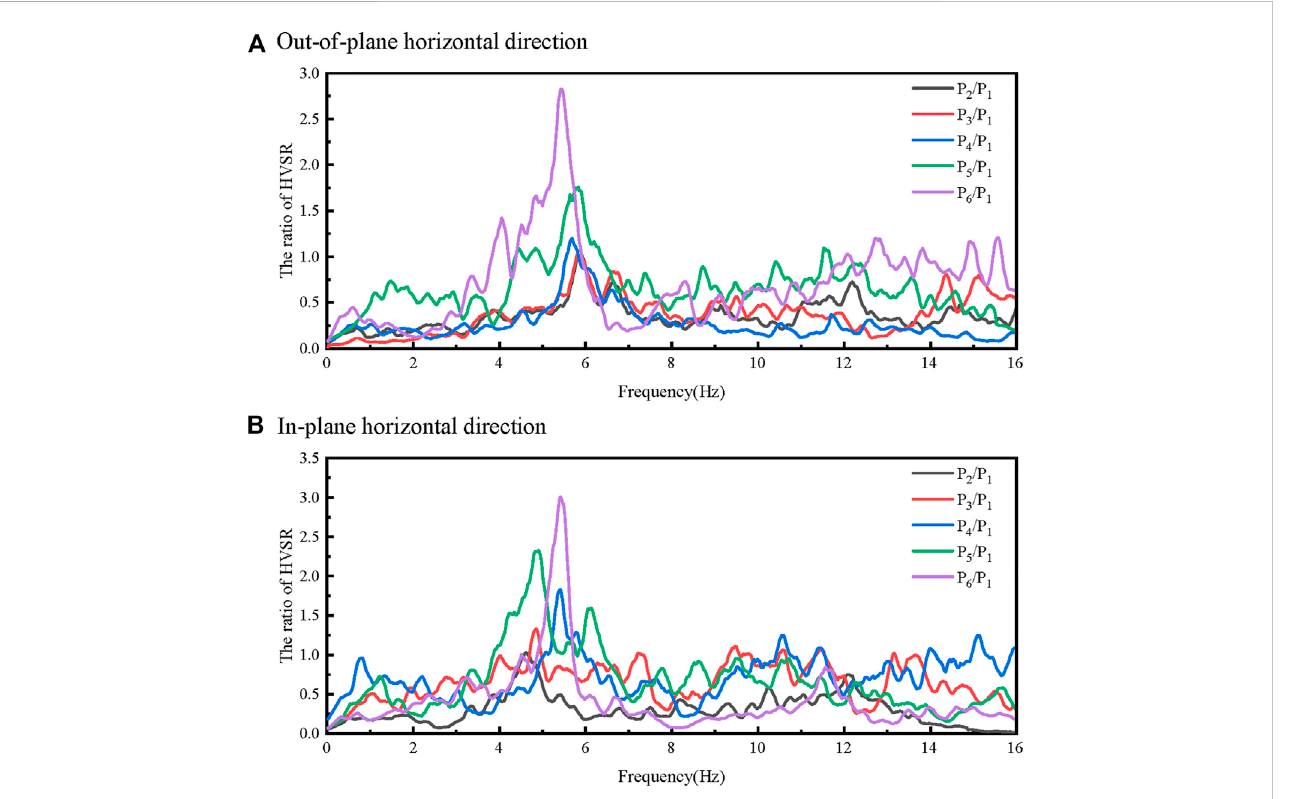
FIGURE 3 The ratio of HVSR between the observation points P 2 – P 6 and P 1 .